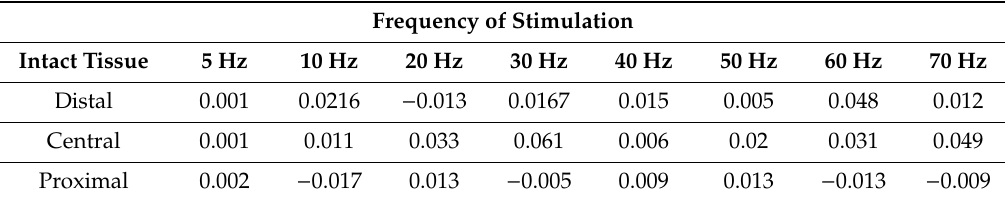
Table 2. Increase in calculated force (grams) generated by the intact tissue after serotonin was added Frequency of